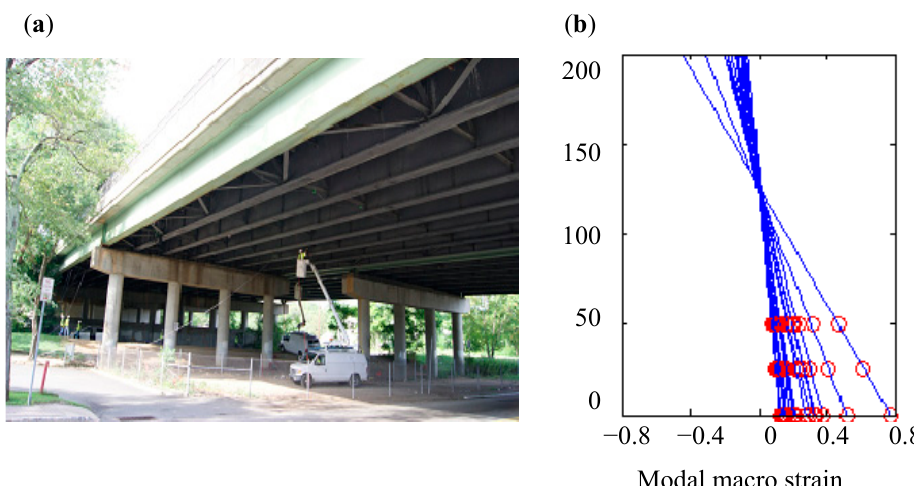
Figure 11. Area-wise distributed monitoring of the multi-girder steel stringer bridge: ( a ) The Investigated Bridge. ( b ) Modal macro strain profile [71].